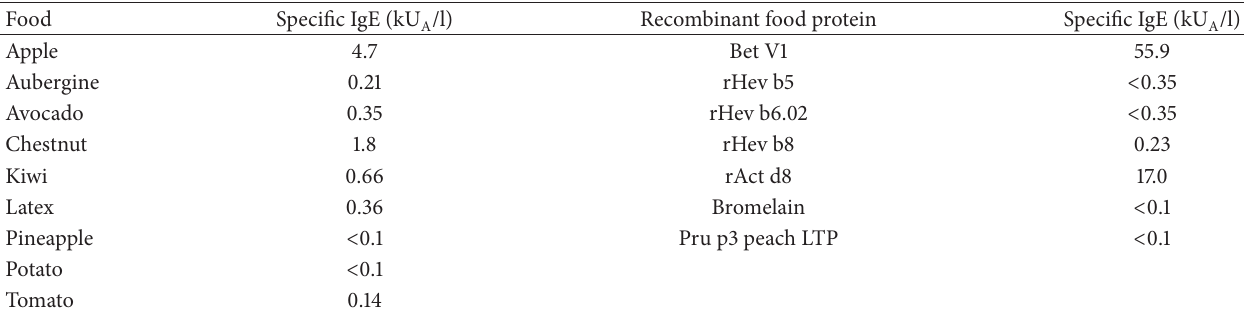
Table 1: Serum specific IgE results to relevant